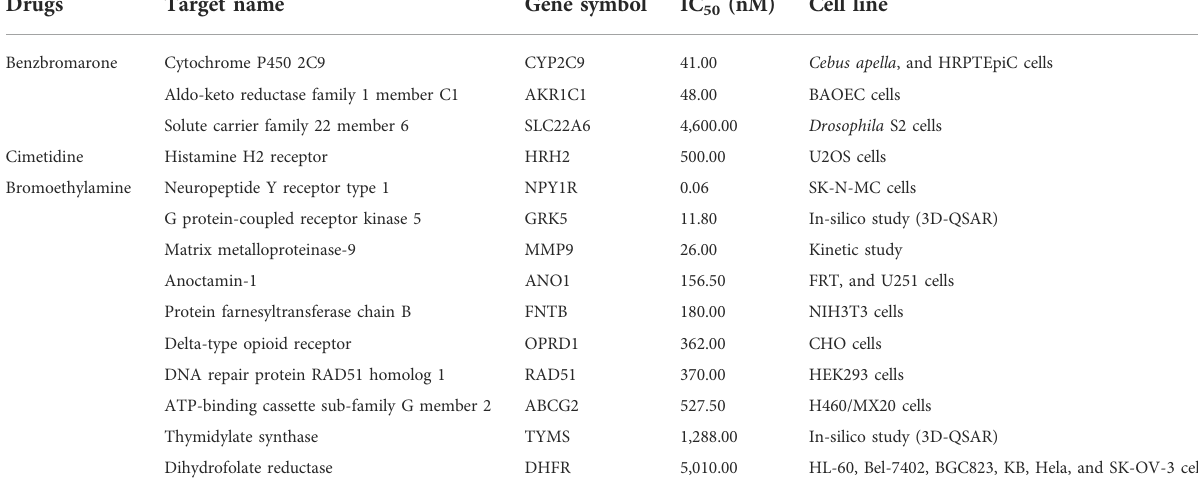
TABLE 3 Physical drug-target interaction pairs and IC 50 values.